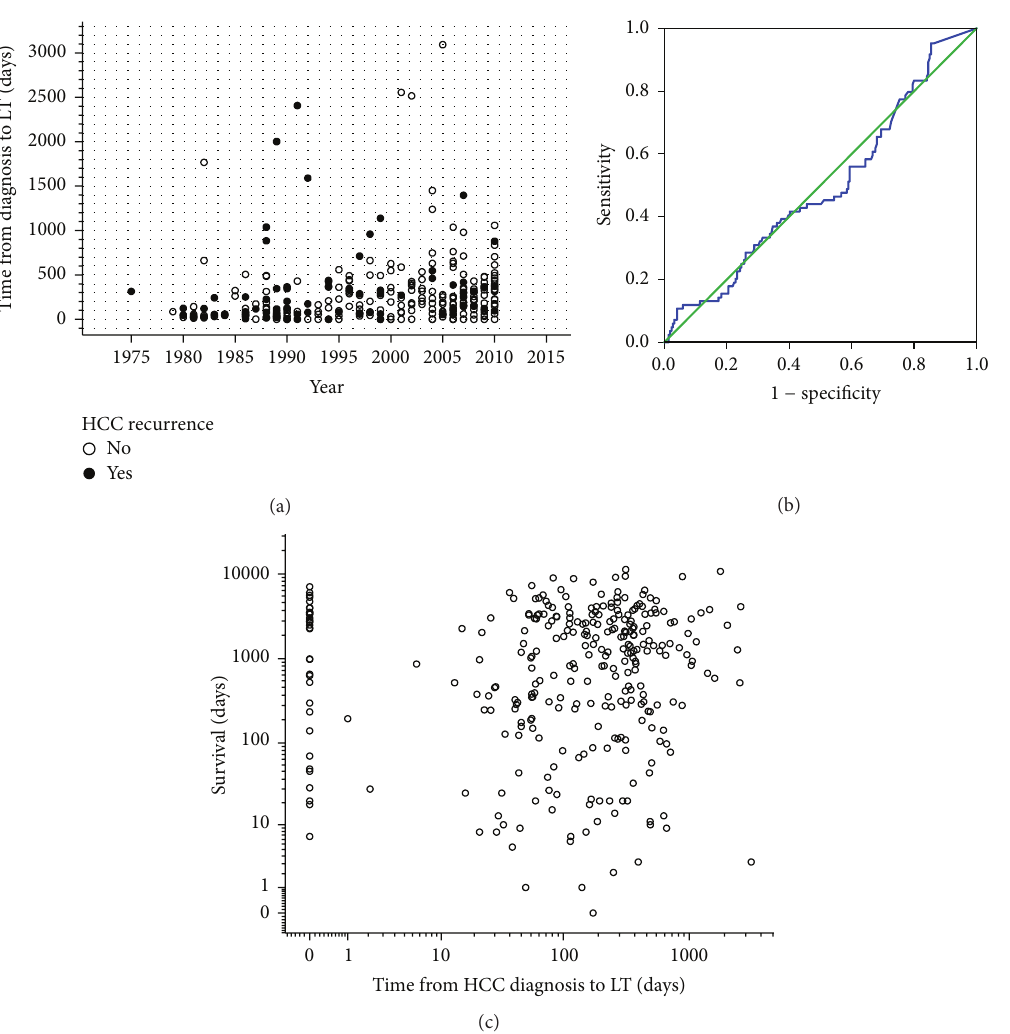
Figure 2: Development of waiting time (b) from 1975 to 2010 and prognostic impact of waiting time on HCC recurrence (b) and overall survival (c). Waiting time increased slightly from about 2-3 months in the early 1980s to an average of 411 days in 2010, but this increase had no significant prognostic impact on HCC recurrence (ROC AUC = 0.494; 𝜒 2 𝑝 = 0.319 ) and overall survival ( 𝜎 2 𝑝 = 0.279